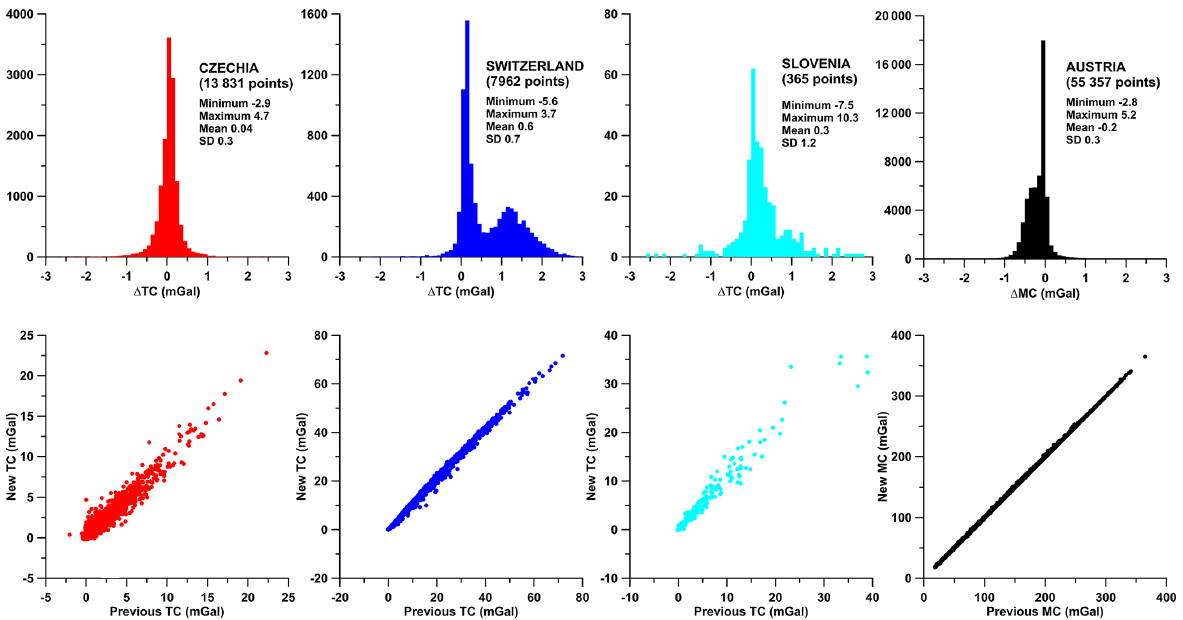
Figure D3. Comparison of original mass correction (or terrain corrections) values and values calculated using local DEMs. Note: there are different scales for each graph.